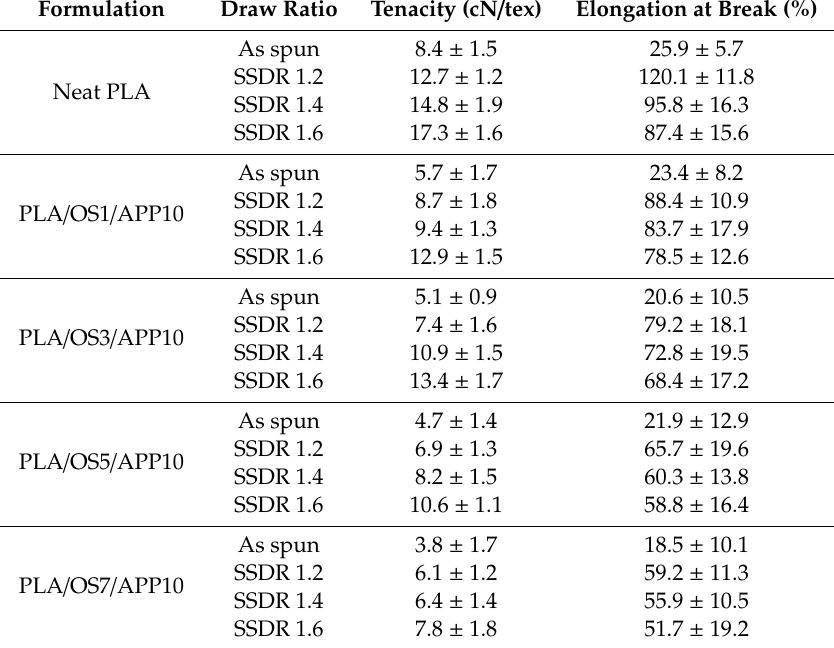
Table 3. Summary of mechanical properties of melt-spun